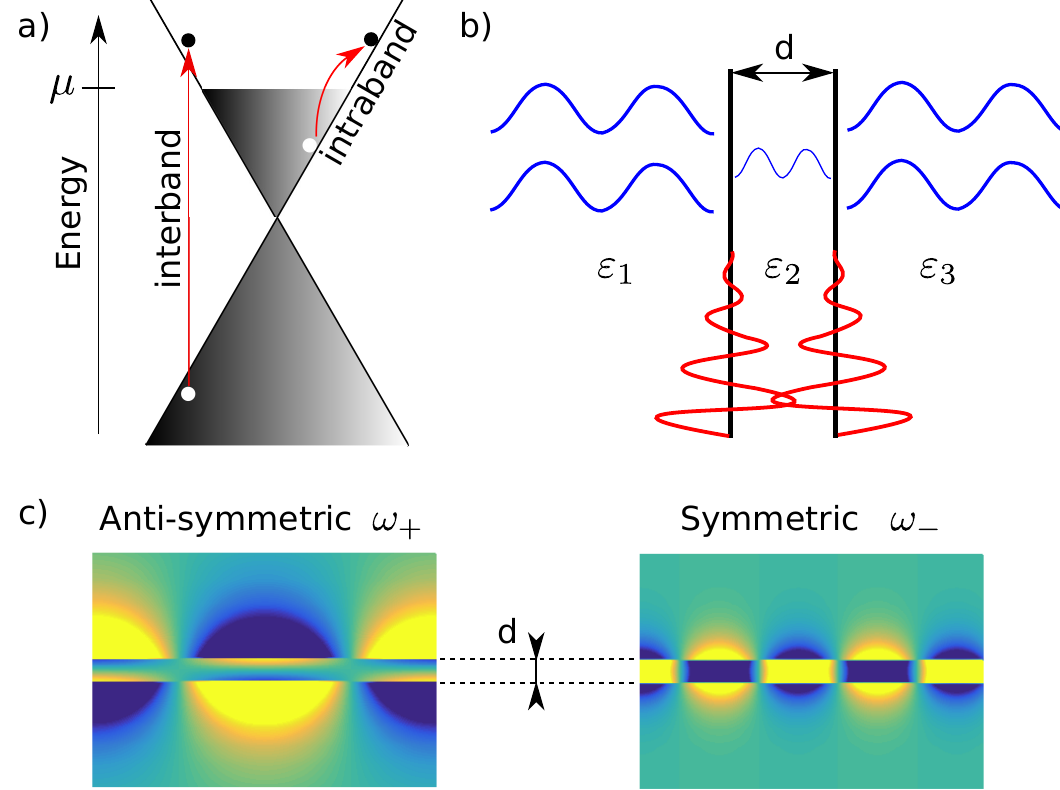
Figure 1. ( a ) Band diagram of doped graphene in the Dirac cone approximation showing interband and intraband transitions at energies E > and < 2 µ respectively. ( b ) Geometry of the graphene sandwich, showing transparency to propagating modes and interaction between highly confined surface plasmons. ( c ) Anti-symmetric (or antibonding) and symmetric (or bonding) plasmon modes between two doped graphene sheets ( µ = 0.5eV) separated by d = 50nm at ¯ h ω =